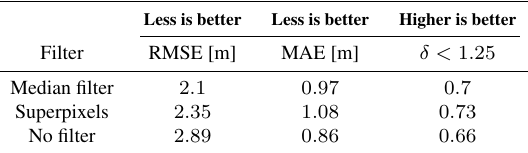
Table 2. Performance evaluation of our method for different filtering strategies. The metrics were computed on our test set.